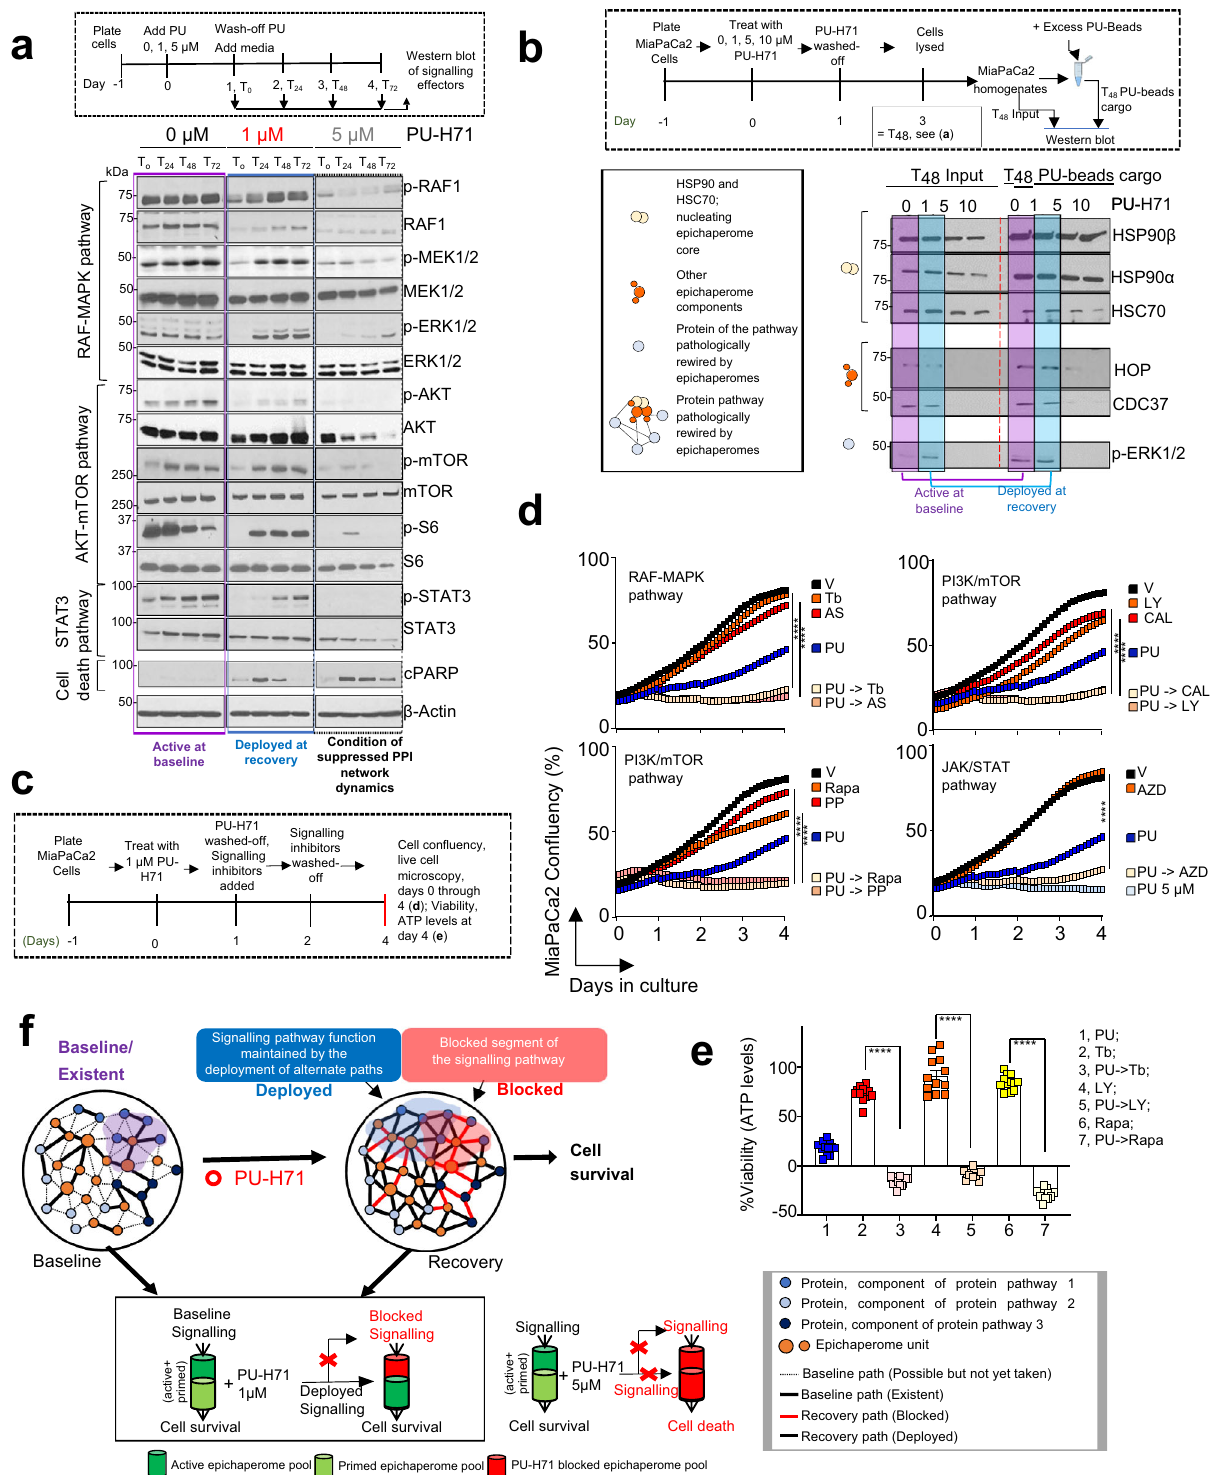
Protein, component of protein pathway 1 Protein, component of protein pathway 2 Protein, component of protein pathway 3 Epichaperome unit Baseline path (Possible but not yet taken) Baseline path (Existent) Recovery path (Blocked) Recovery path